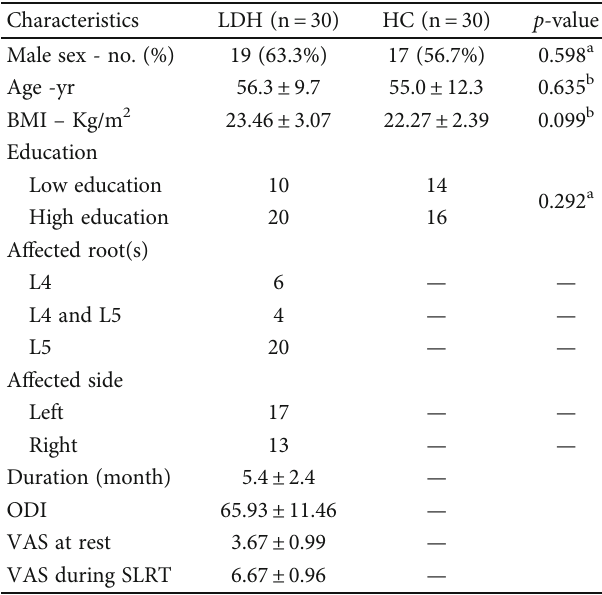
Table 1: Demographic characteristic of the lumbar disc hernia induced unilateral lumbar nerve root compression and healthy control